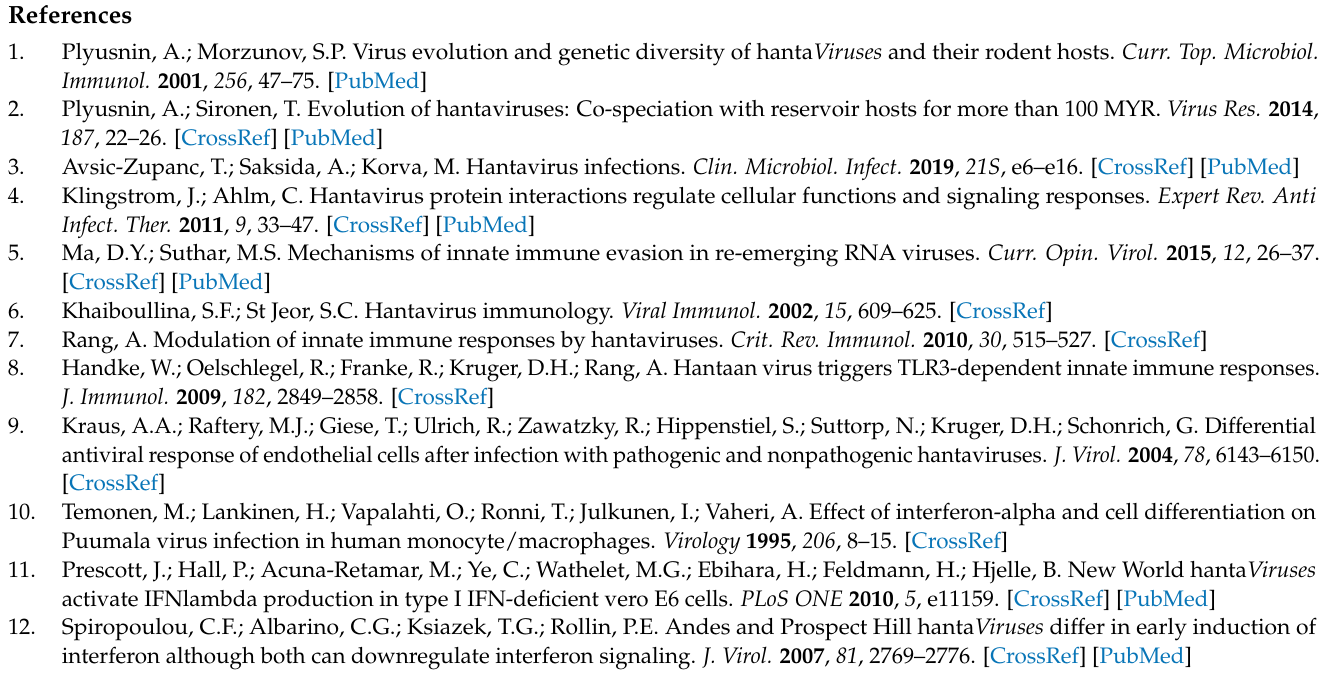
Figure S2: Cellular localization of PUUV and TULV NSs proteins coupled to different tags, Figure S3: Effect of viral proteins on TBK1, IRF3 or STAT1 expression and activity. Table S1: (a) Primers used to clone viral sequences in the Gateway system, (b) Primers used for site-directed mutagenesis to validate predicted NoLS regions of NSs, (c) Primers used to quantify mRNA expression of human genes. Table S2: Amino acid sequences of mutant or truncated NSs used in luciferase assay, Table S3: Genes down-regulated in PUUV infected A549